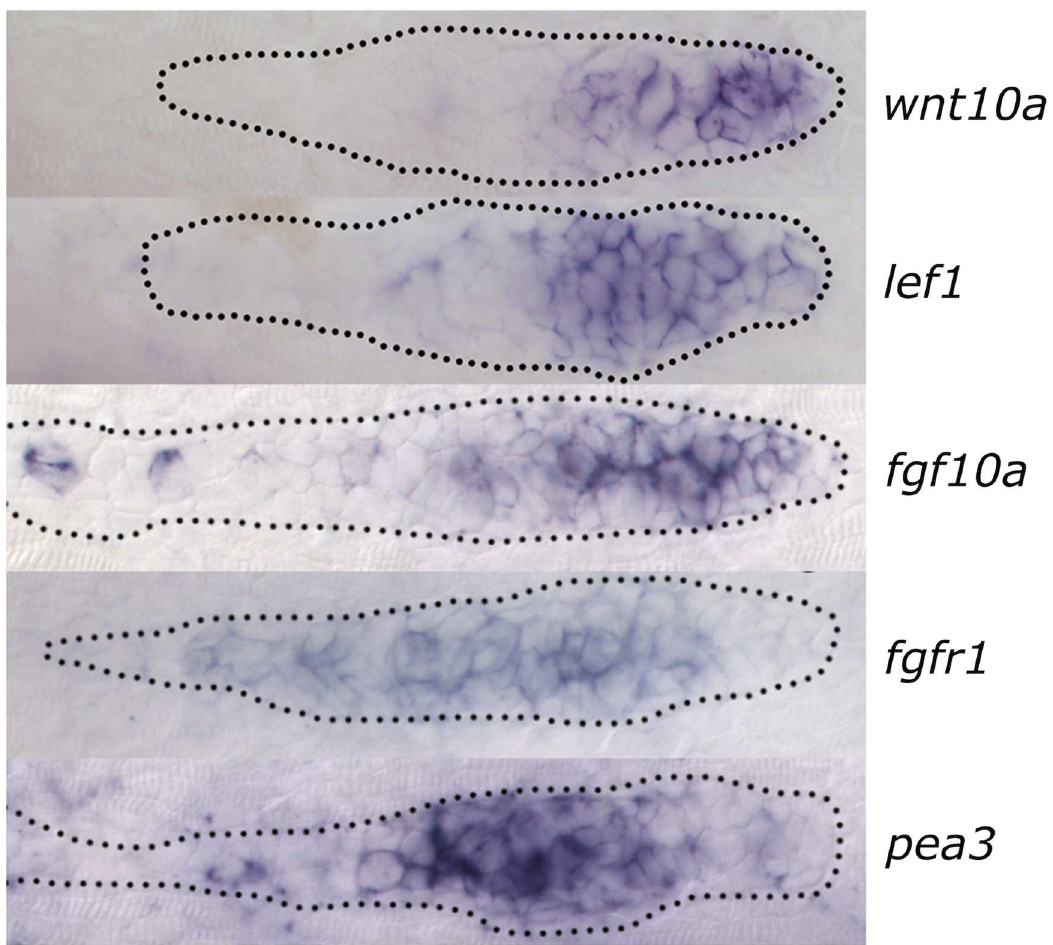
Fig 7. Experimentally observed Wnt and FGF expression and signalling levels. RNA in-situ hybridization showing expressionat 32 hours post fertilization in the PLLP. From top to bottom these are: wnt10a (Wnt ligand), lef1 (Wnt signalling), fgf10a (FGF ligand),fgfR1 (FGF receptors) and pea3 (FGF signalling).The scale bar is 10 μ m.